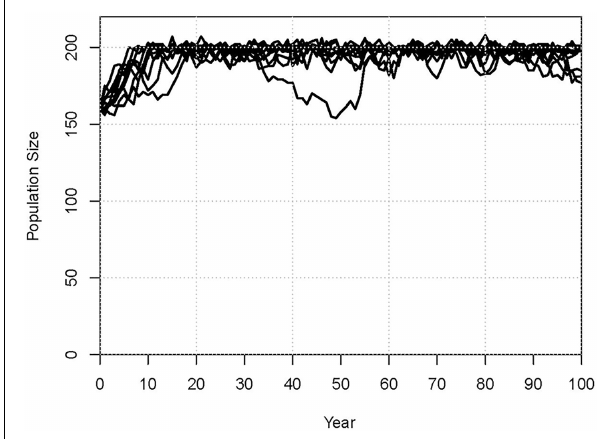
FIGURE 4 | Effect of additional mortality (scaled as proportional reduction of survival) on projected mean population growth.